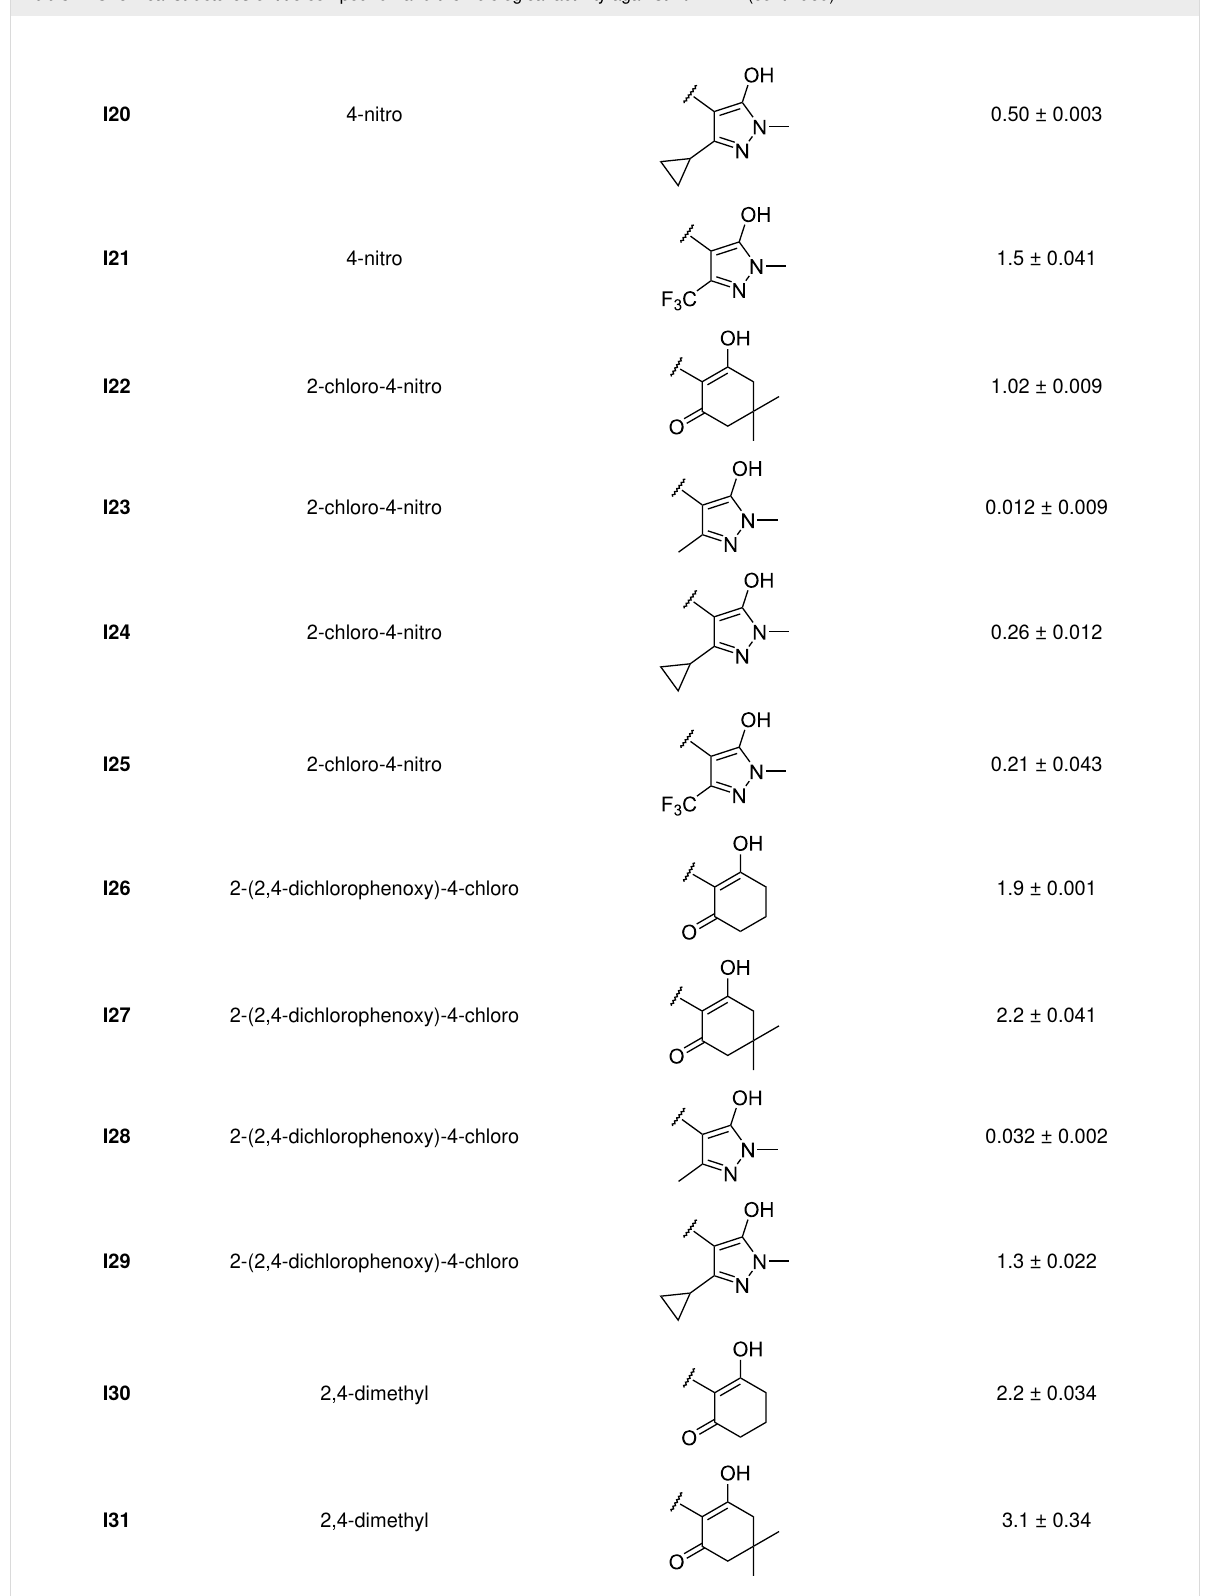
Table 1: Chemical structures of title compound I and their biological activity against At HPPD.